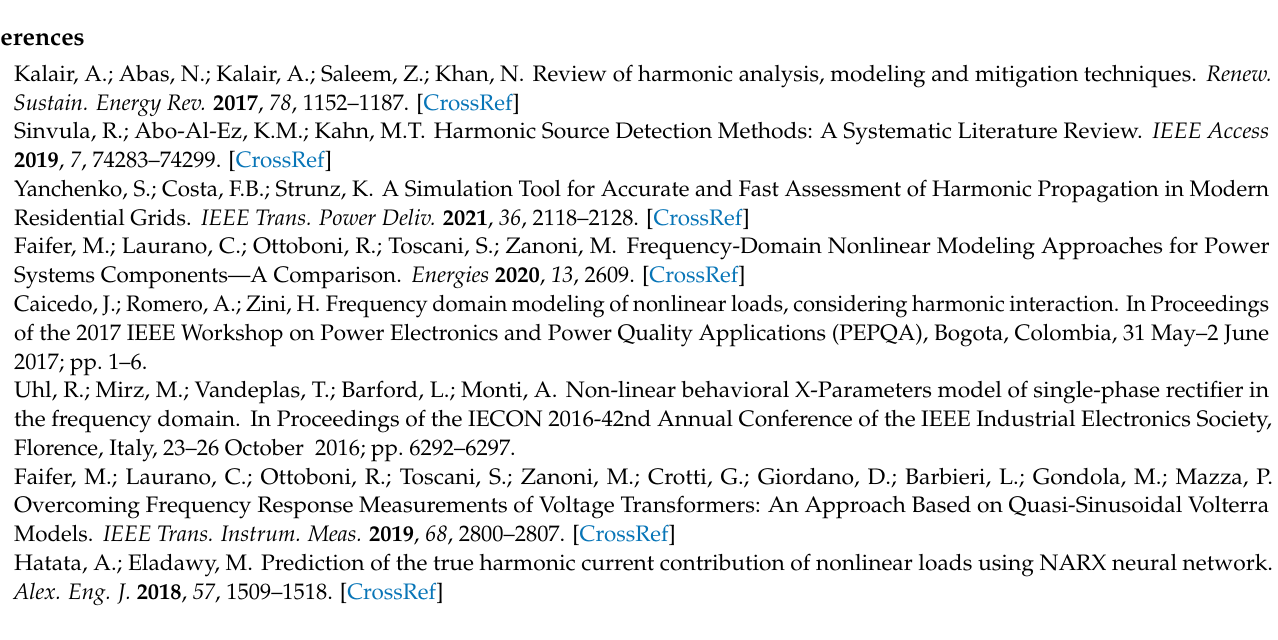
Figure·S4: PS1: Illustration of the signal variability over multiple time-synchronized periods. Mul- tiple overlapped single periods of the same signal are presented.; Figure S5: PS2: An example of the fluctuations of harmonics power modeled by lognormal distribution (similar to Figure 4 in the paper); Figure S6: PS2: Histogram fits of lognormal distribution for different harmonics and different DC load levels (similar to Figure 5 in the paper); Figure S7: PS2: Box-plot of the levels of the different harmonics power as a function of DC load current (similar to Figure 7 in the paper); Figure S8: PS2: ACF of harmonics powers for different frequencies (similar to Figure 8 in the paper); Figure S9: PS2: Even harmonics at high load can only barely be lognormal modeled (similar to Figure 11 in the paper); Figure S10: PS2: Correlation of harmonics coefficients (similar to Figure 9 in paper); Figure S11: PS3: An example of the fluctuations of harmonics power modeled by lognormal distribution (similar to Figure 4 in the paper); Figure S12: PS3: Histogram fits of lognormal distribution for different harmonics and different DC load levels (similar to Figure 5 in the paper); Figure S13: PS3: Box-plot of the levels of the different harmonics power as a function of DC load current (similar to Figure 7 in the paper); Figure S14: PS3: ACF of harmonics powers for different frequencies (similar to Figure 8 in the paper); Figure S15: PS3: Correlation of harmonics coefficients (similar to Figure 9 in paper); Figure S16: PS3: In this case harmonics at high load are still close to the lognormal model (see Figure 11 in the